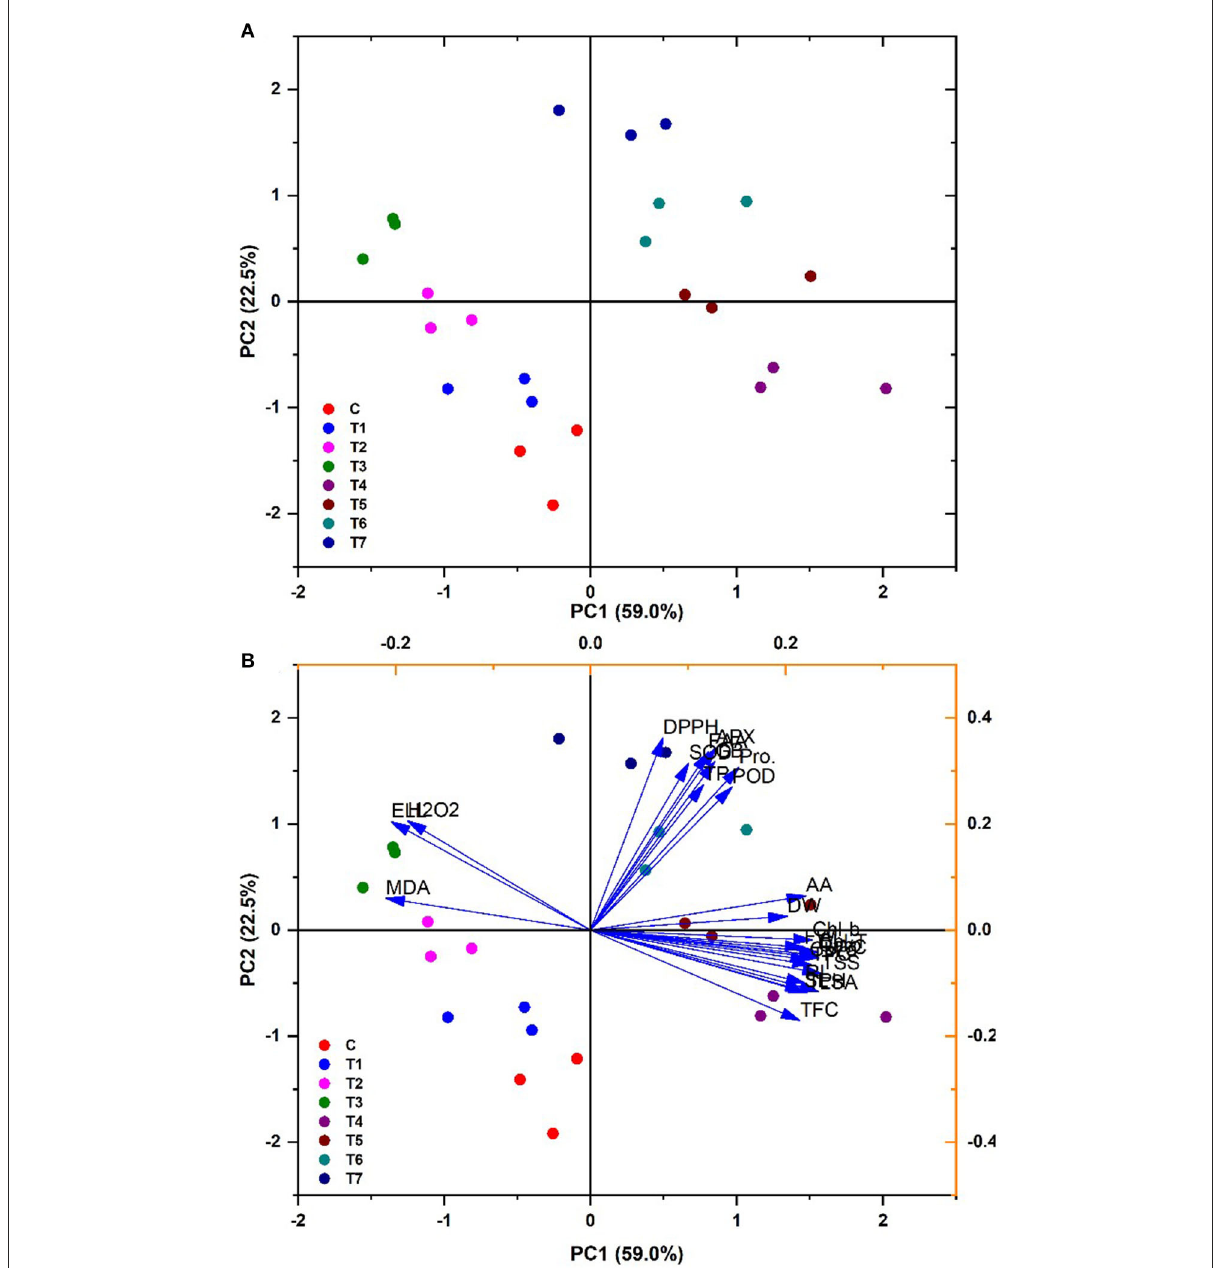
FIGURE7 PCA biplot showing the categorization of PM25 based on its effects on maize growth-promoting characteristics under salinity stress (A) Cluster analysis (B) PCA Biplot analysis.